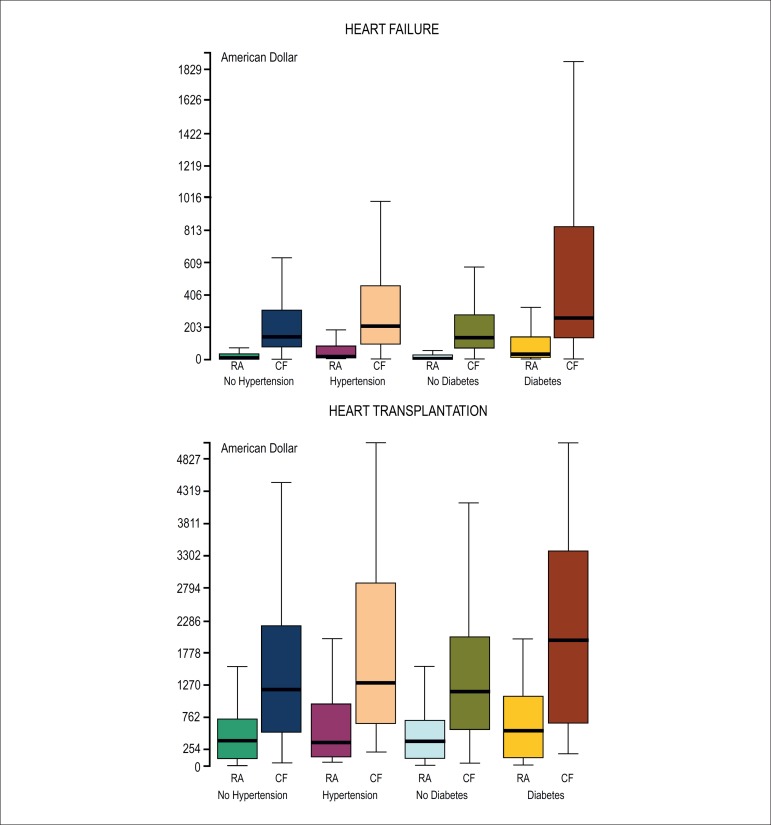
Cost of delivered prescription drugs purchased via reverse auction (RA)
compared with commercial pharmacy (CP) costs according to the diagnosis of
systemic arterial hypertension and diabetes mellitus in heart failure and heart
transplantation.